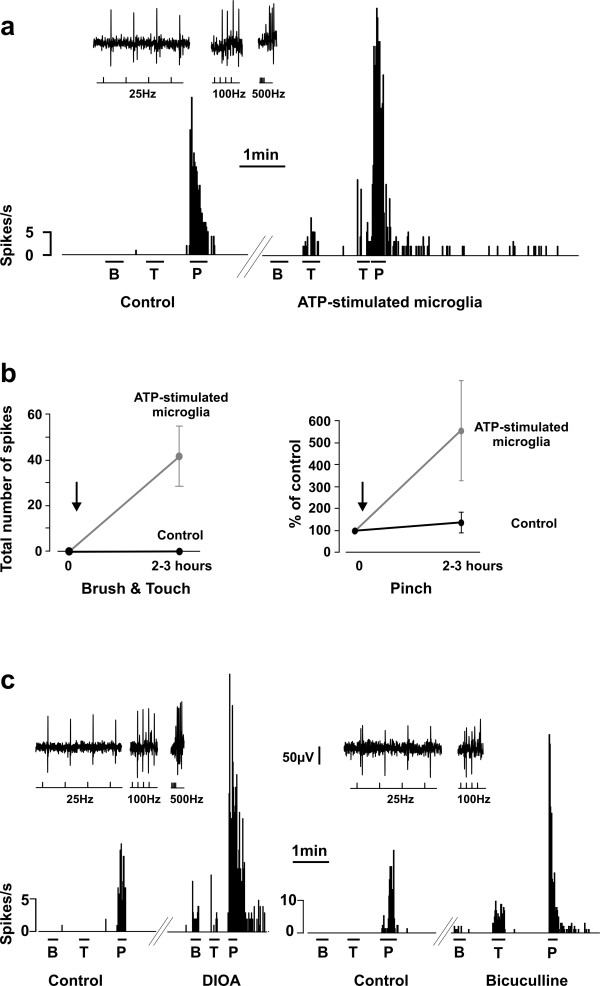
Stimulated microglia, disruption of chloride homeostasis and bicuculline alter the sensory selectivity of nociceptive specific lamina I projection neurons. a. Rate meter records at the top show the response of an identified lamina I projection neuron to natural mechanical stimulation of the receptive field (B = Brush; T = Touch; P = Pinch). The inset shows antidromic spikes from the parabrachial nucleus following our protocol for identification of projection neurons (see methods and Fig. 1b). b. Graphs showing the population data (values indicate mean ± SEM). To avoid biasing the results because of heterogeneity in responses between cells, values are expressed as a percent of control response for each cell. While none of 30 nociceptive specific lamina I projection neuron tested showed occurrence of responses to innocuous input (neither brush or touch) in control conditions after up to 4 hours of recording, all four nociceptive specific cells tested showed a significant response to innocuous input (brush and touch) within 2–3 h of local administration of ATP-stimulated microglia on the surface of the lumbar spinal cord. c. Blockade of cation-chloride co-transporters with local spinal administration of DIOA, or blockade of GABAA receptors with bicuculline unmasked innocuous input (brush and touch) to nociceptive specific lamina I projection neurons in control animals.